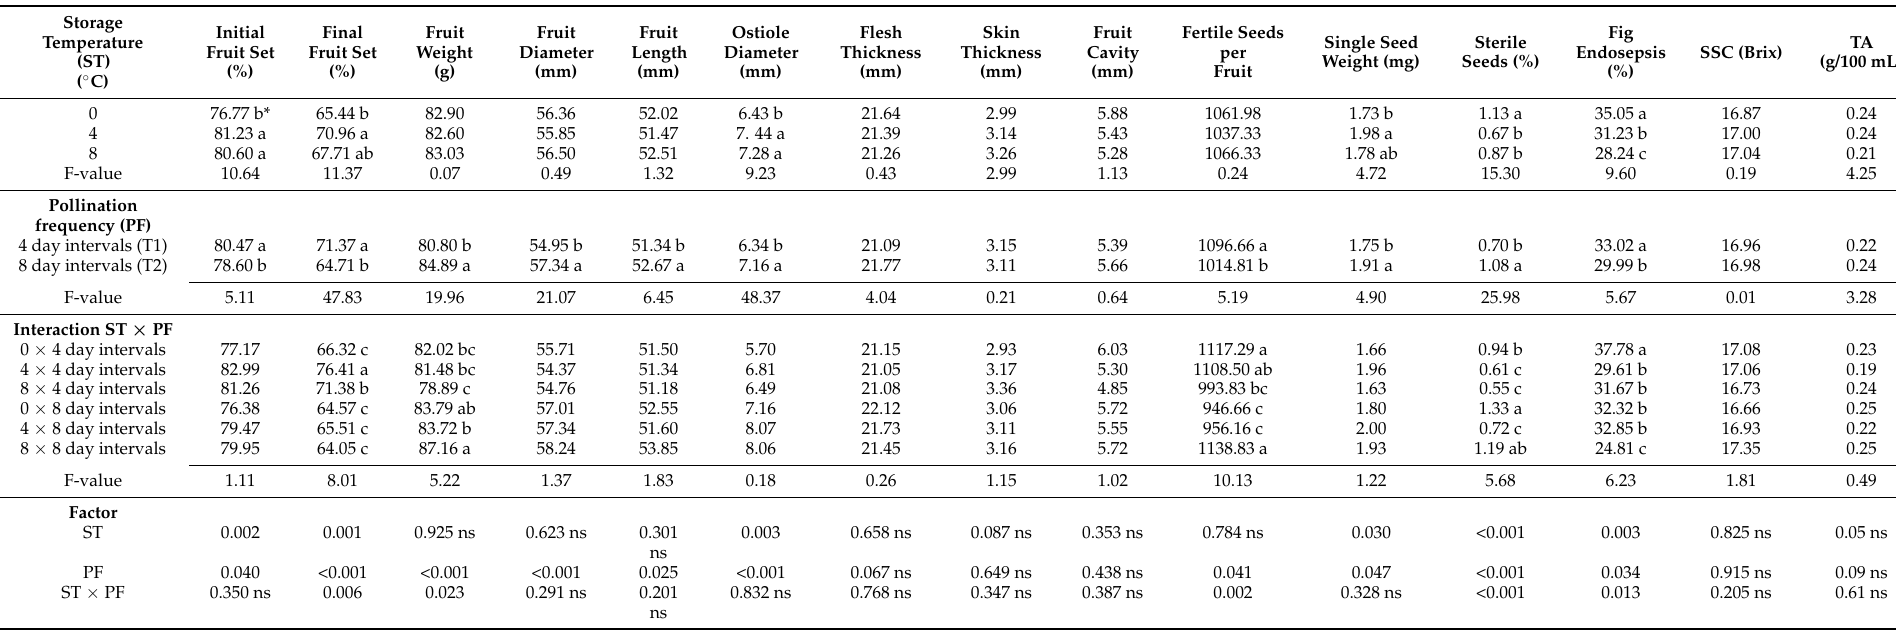
Table 2. The effect of storage temperature, pollination frequency, and their interaction on the fruit characteristics of the ‘Bursa Siyahı’ fig